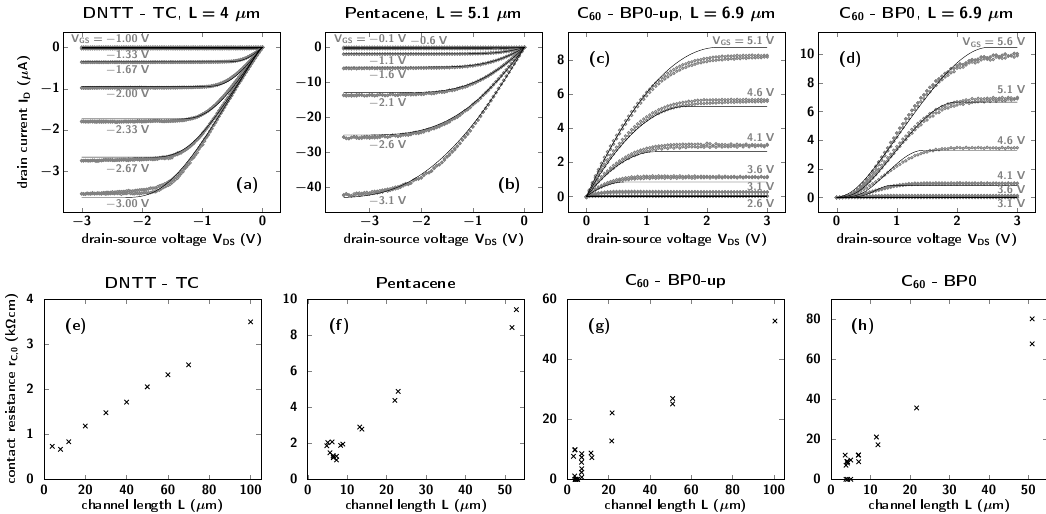
Figure 6. Selected examples of output characteristics for each set of TFTs ( a – d ) and Ohmic component of the combined contact resistance r C ,0 plotted as a function of the channel length for each set of organic TFTs ( e – h ). In (a,e), bottom-gate, top-contact DNTT TFTs are investigated. In (b–d) and (f–h), bottom-gate, bottom-contact pentacene and C 60 TFTs with Au contacts functionalized with 2-phenylpyrimidine-5-thiol (BP0-down), 4-(2-mercaptophenyl)pyrimidine (BP0-up), or biphenyl-4-thiol (BP0) are analyzed. For all TFTs, despite different TFT architectures, different organic semiconductors, and different contact materials, a clear channel-length dependence of the Ohmic component of the contact resistance r C ,0 is observed. This leads to a failure of the transistor model in all cases. The substantial fluctuations of r C ,0 in the short-channel-length C 60 TFTs in (g,h) (including transistors with r C ,0 = 0) reflect the fact that the uncertainty of the Ohmic contact resistances for these small channel lengths is on the order of the actual value. This large uncertainty does not obscure the clear increase of the contact resistance r C ,0 with the channel length L . The failure appears to occur for the same reason as seen for the bottom-gate, bottom-contact DNTT TFTs, because the symptom of an incorrect spacing in the saturation regime of the output characteristics is present here as